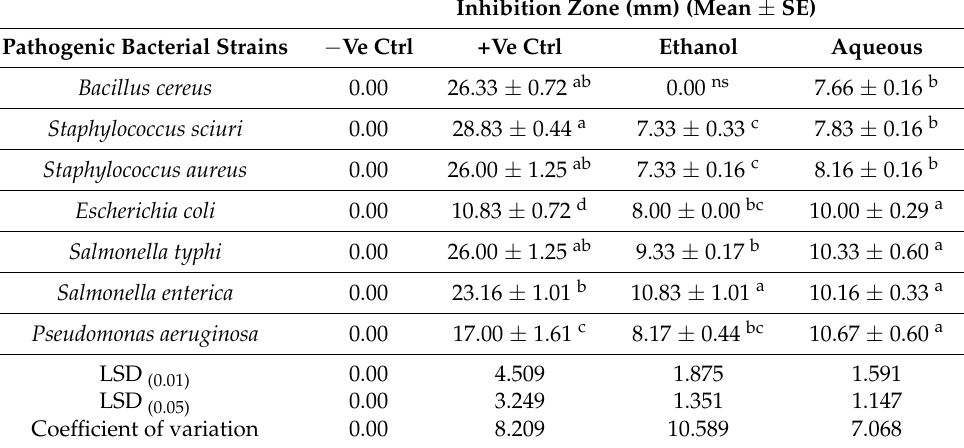
Table 4. Antibacterial activity of Moringa ethanolic and aqueous extracts against different bacterial strains by disc diffusion method.